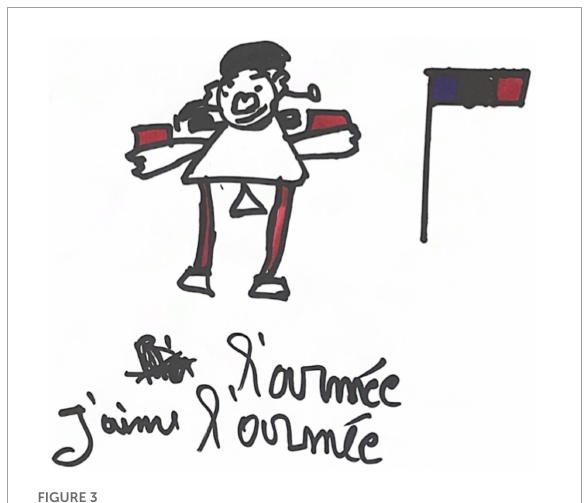
FIGURE3 Drawing of a girl who wants to join the